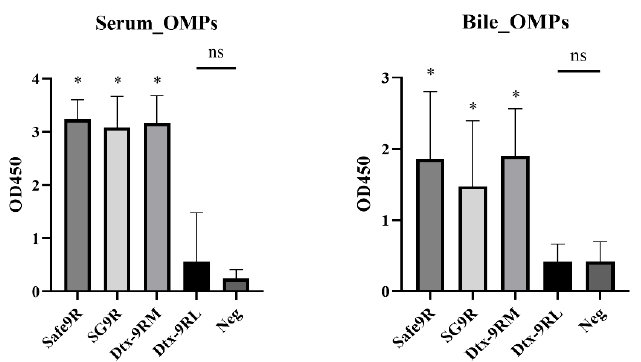
Figure 6. Humoral and mucosal immunogenicity of live vaccines with the detoxified strains after challenge. Detoxified vaccines were inoculated in 1 week-old chicks and the virulent field strain was challenged after 1 week of vaccination. Blood and bile samples were collected after 2 weeks of the challenge and analyzed with the ELISA. Statistical significance indicated as follows: ns not significant, * significantly different compared with Neg ( p < 0.05).